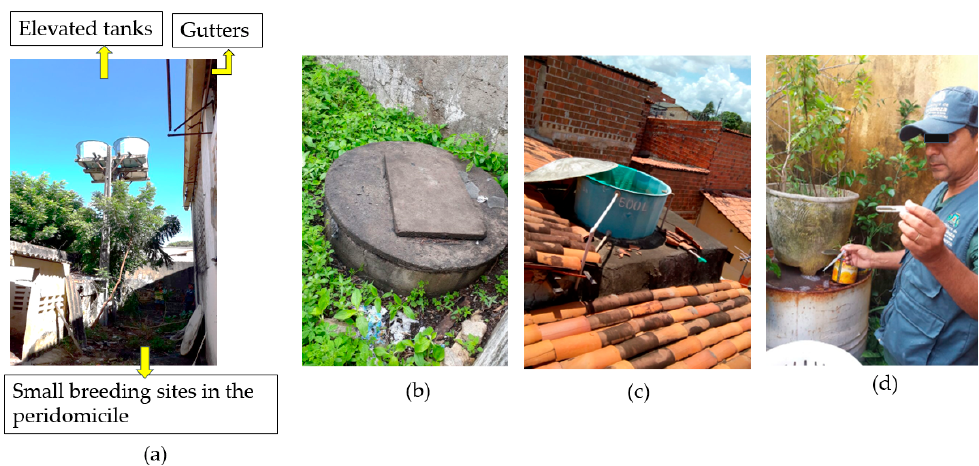
Figure 4. Breeding sites. ( a ) Elevated tanks, gutters and small breeding sites, ( b ) waterhole, ( c ) elevated tanks, ( d ) flower pot and large drum.